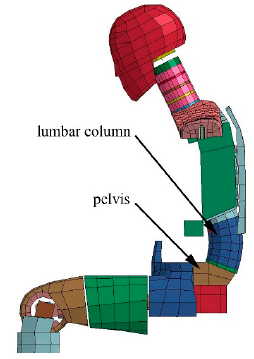
Figure 3. Mechanical model of the human–seat coupling system during the collision.